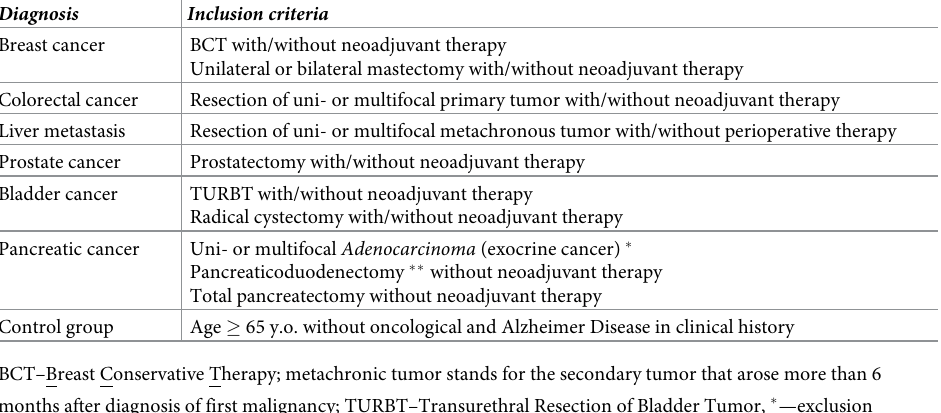
Table 1. Inclusion and exclusion criteria for each